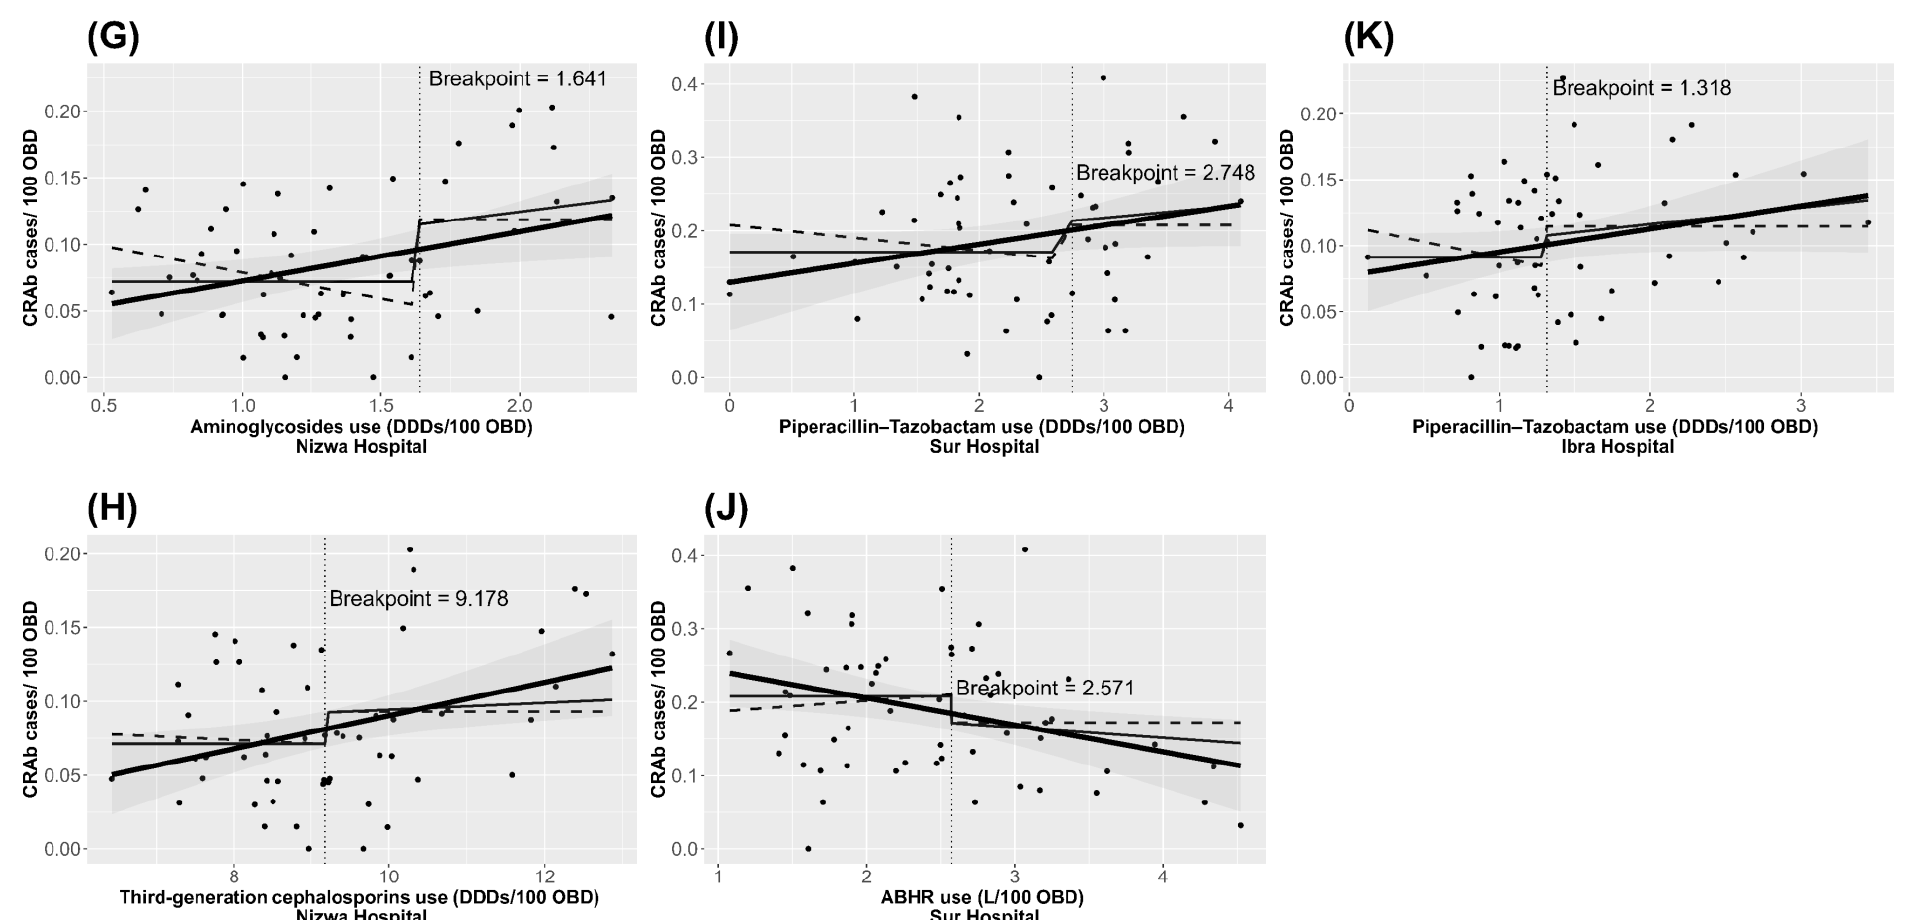
Figure 1. Charts illustrating the identified thresholds for antibiotic ( A , C – I , K ) and ABHR ( B , J ) use and their effect on CRAb incidence trends, January 2015 to December 2019 in hospitals in Oman. The thick black line is the fitted linear regression line of the unsegmented data. The thin black line is the fitted linear regression line focusing on x > threshold and the dashed black line focuses on x < threshold.